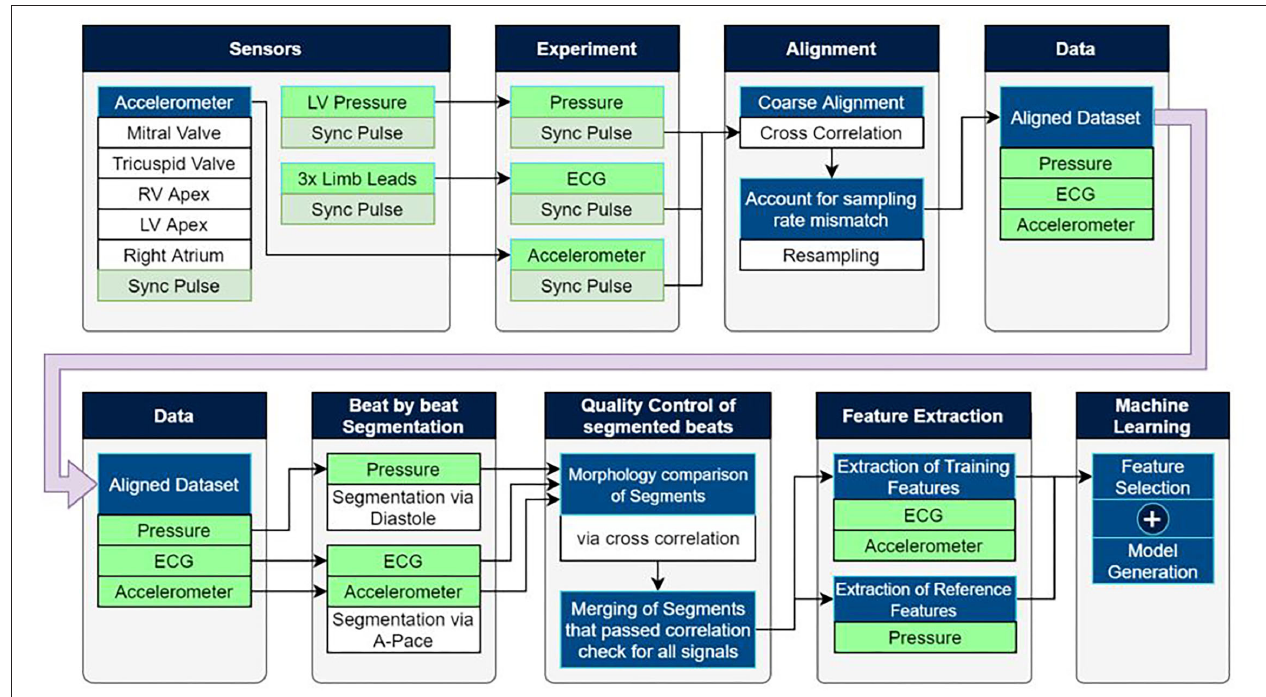
FIGURE 1 | Experimental setup as well as the post-processing pipeline used to extract training data for machine learning based estimation